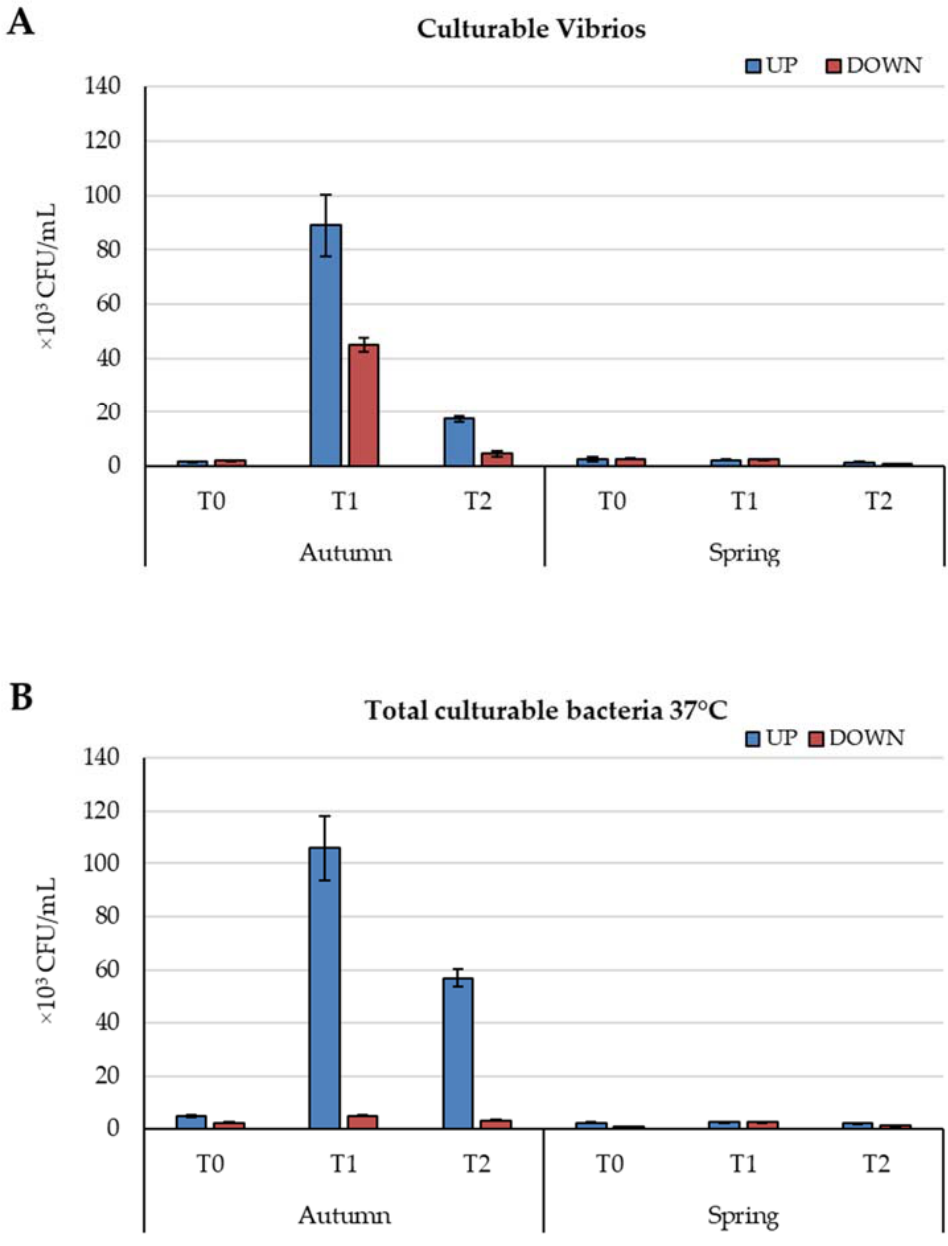
Figure 2 . Culturable Vibrios ( A ) and total culturable bacteria at 37 °C ( B ) mean values ± standard errors in wastewater upstream (UP) and downstream (DOWN) of Hymeniacidon perlevis at each sampling time (T0, T1, T2) during both sampling periods (autumn and spring).